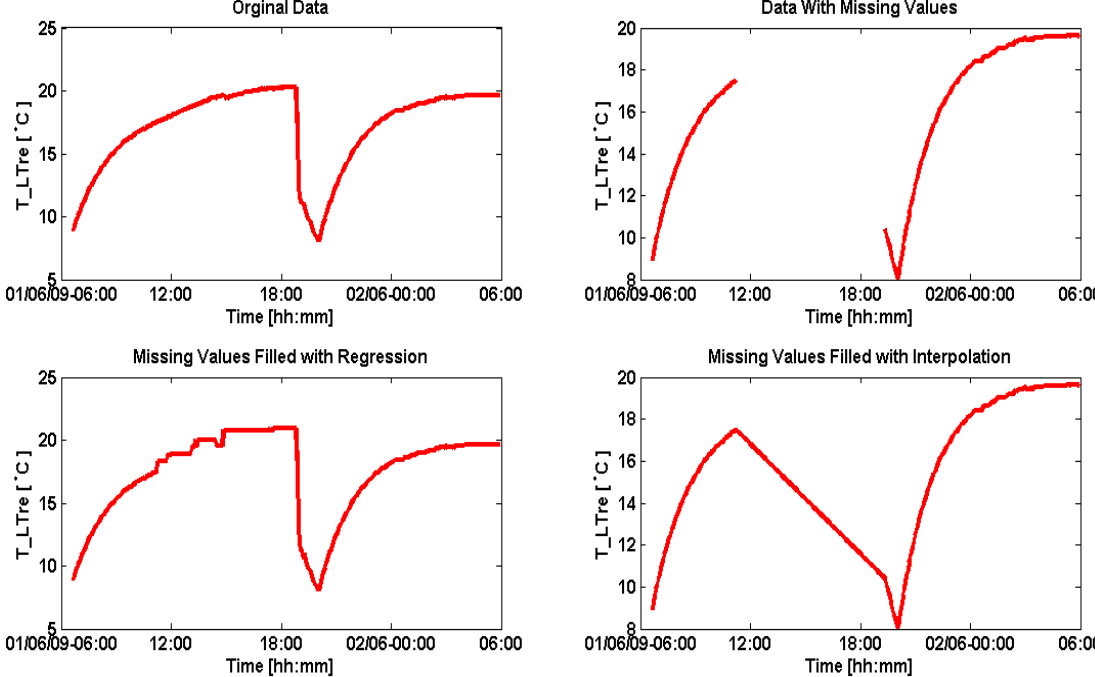
Figure 12. Sanitation of large gaps using regression.